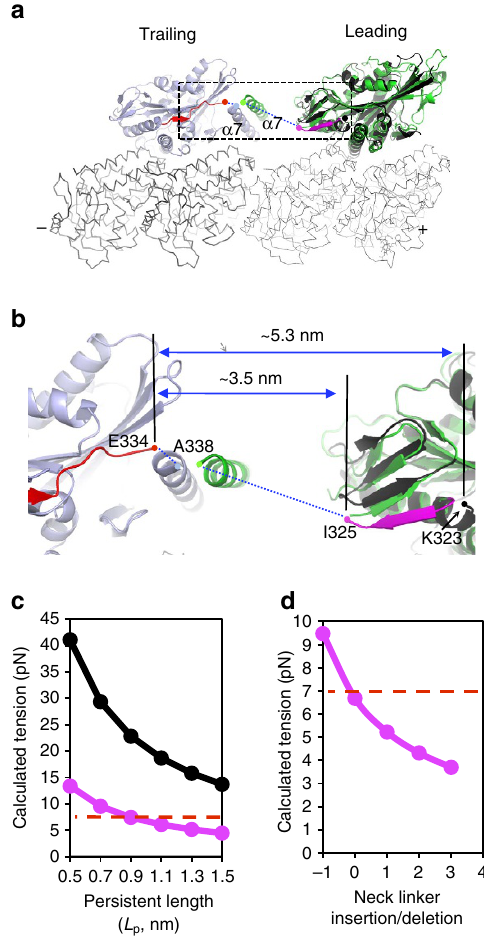
Figure 5 | Model and the estimated intramolecular tensions in the 2HB state. ( a ) Overlay of the current and previous models of kinesin in the 2HB state. These two models differ at the leading heads, which are coloured green (modelled with Zen4) and black (modelled with kinesin-1, PDB code 4LNU), respectively. The trailing head (modelled with kinesin-1, PDB code 3J8Y), tubulin, backward-docked NIS (current model) and forward-docked NL are coloured light blue, grey, magenta and red, respectively. The neck helixes are labelled a 7 (starting from Ala338, PDB code 3KIN) and the disordered neck linkers are showed as dotted lines. The boxed region is zoomed up for further analysis in ( b ). In the current model, the last ordered residues at the C-termini of the leading and trailing heads are ILe325 (magenta dot) and Glu334 (red dot), respectively, which span a distance of B 3.5nm with a total of 17 disordered residues (defined by the end of a 6 and the start of a 7). In the previous model, the last ordered residues of the leading is Lys323 (black dot), and connects to the trailing head over a distance of B 5.3nm and with a total of 19 disordered residues. ( c ) Intramolecular tensions of kinesin-1 in the 2HB state calculated based on the WLC model with different values of L p . The magenta and black lines indicate the calculated forces based on the current and previous models, respectively. The red dashed line indicates the unbinding/stall force ( B 7pN). ( d ) Calculated intramolecular tension of kinesin-1 in the 2HB state with different insertion/deletion in the neck linker region. 0 indicated WT kinesin, and (cid:2) 1 indicated deletion of one residue in the neck linker. The calculations were done at L p ¼